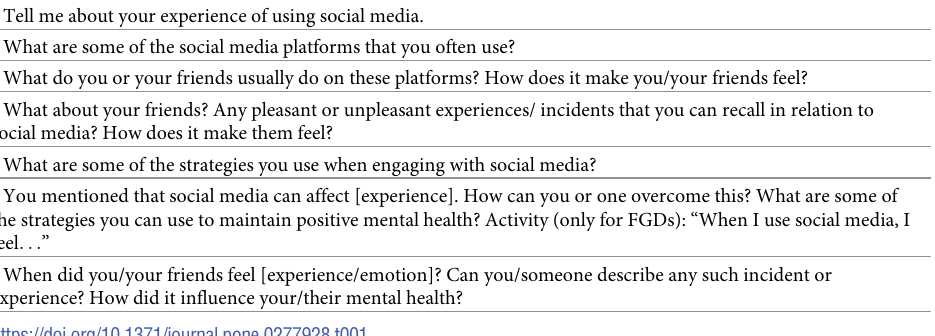
Table 1. Interview guide to examine the harms of social media and strategies youth adopt to mitigate those